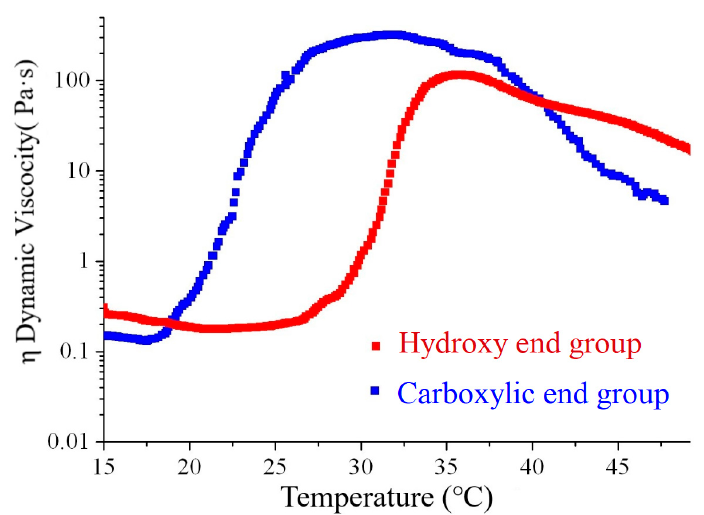
Figure 7. Dynamic mechanical analysis of hydroxyl terminated and carboxylic terminated PECP copolymer solutions (25 wt %) as a function of temperature.